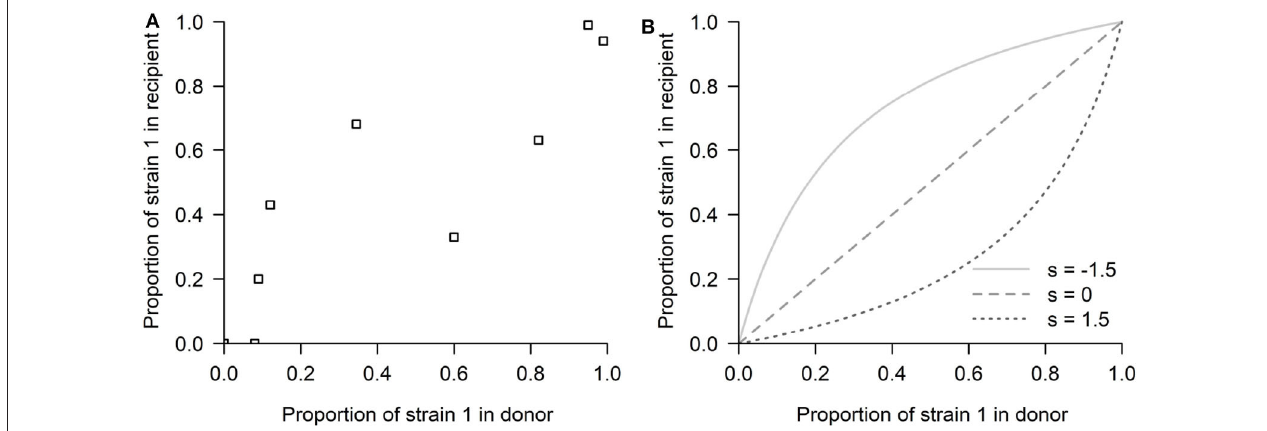
FIGURE 2 | The competitive-mixtures data and the exponential model. (A) The donor-recipient data for competitive mixture transmission of influenza viruses analyzed by McCaw et al. (2011) (reproduced using the R software, after Figure 7 in Hurt et al., 2010). The abscissa shows the mutant proportion of the infecting ferret’s viral load on the day preceding confirmed transmission. The ordinate shows the mutant proportion of the infected ferret’s viral load within the first 24 h post-infection. Thus, the time passed between the two observations can be approximated to be 2 days. (B) The exponential model possibilities depending on the selection coefficient s : ( s < 0) Mutant advantage, or ( s > 0) WT advantage, thus expecting all the points above or below the diagonal, in a competitive exclusion